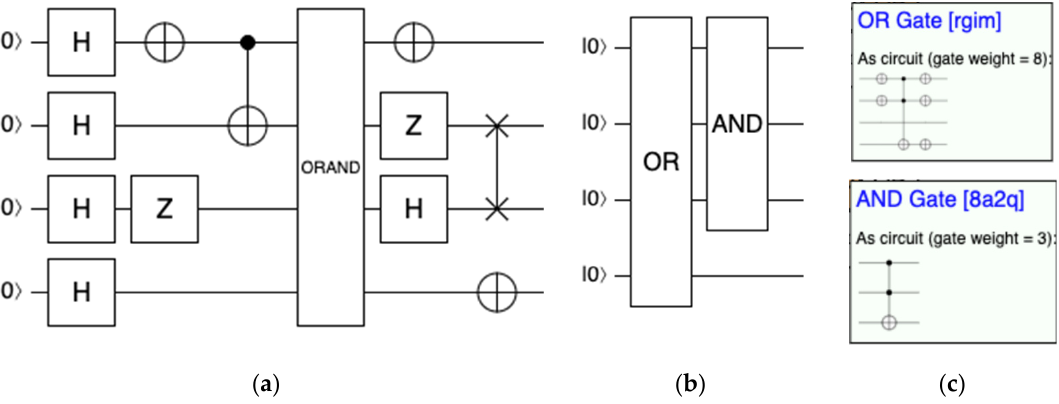
Figure 10. ( a ) A sample of a circuit embedding a module with communicational cohesion. ( b ) The implementation of the module including OR/AND submodules. The tasks performed within the module (AND/OR operations) share the first three incoming qubits as input data. ( c ) Detail of the implementation of the submodules.